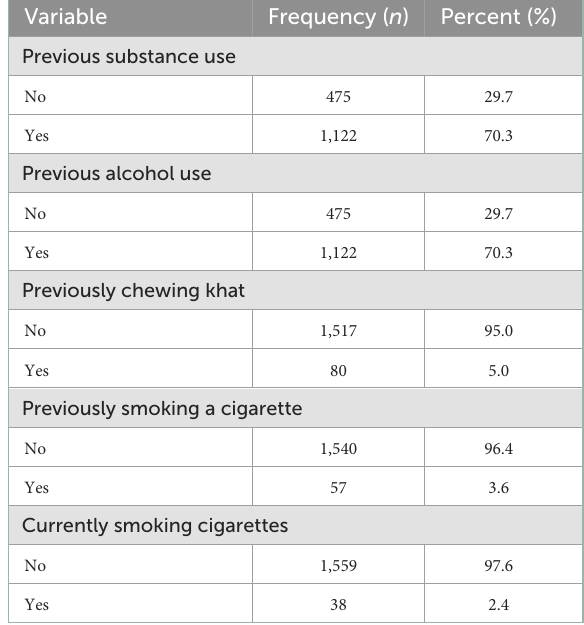
TABLE 2 Clinical and social characteristics of youths living in the central, west, and north Gondar zones. Variable